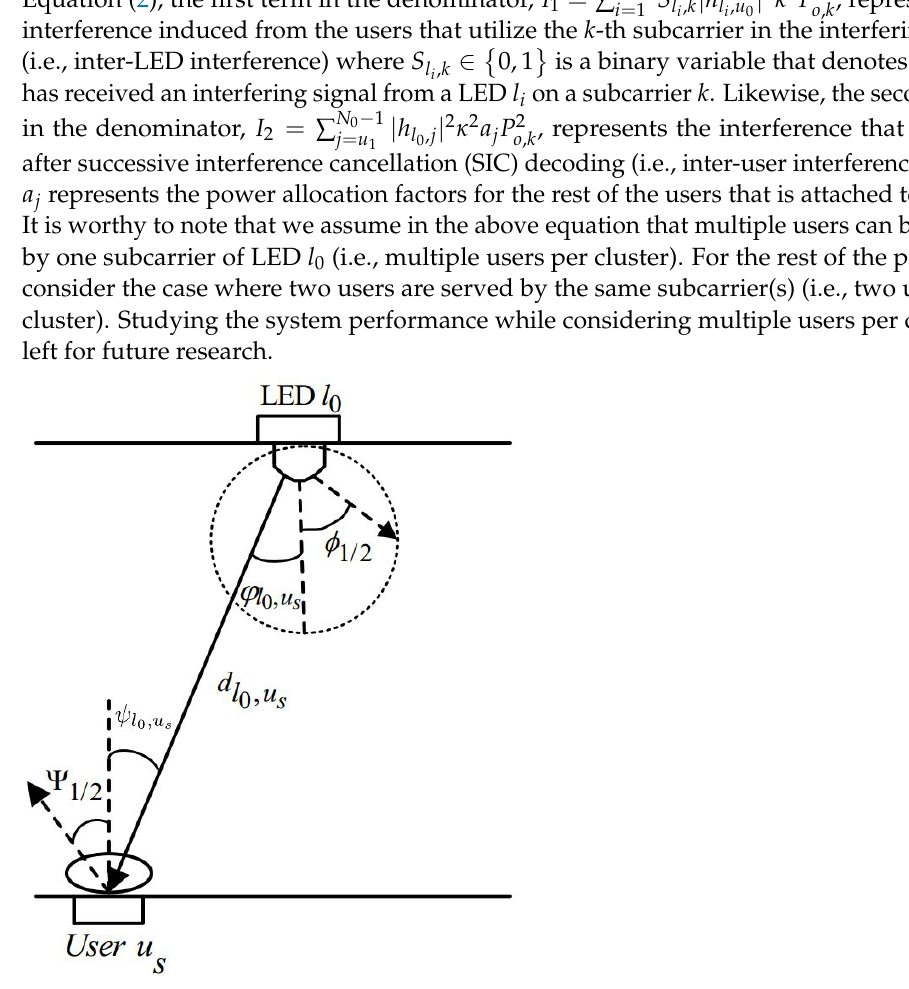
Figure 2. The LoS channel model between LED l 0 and user u s